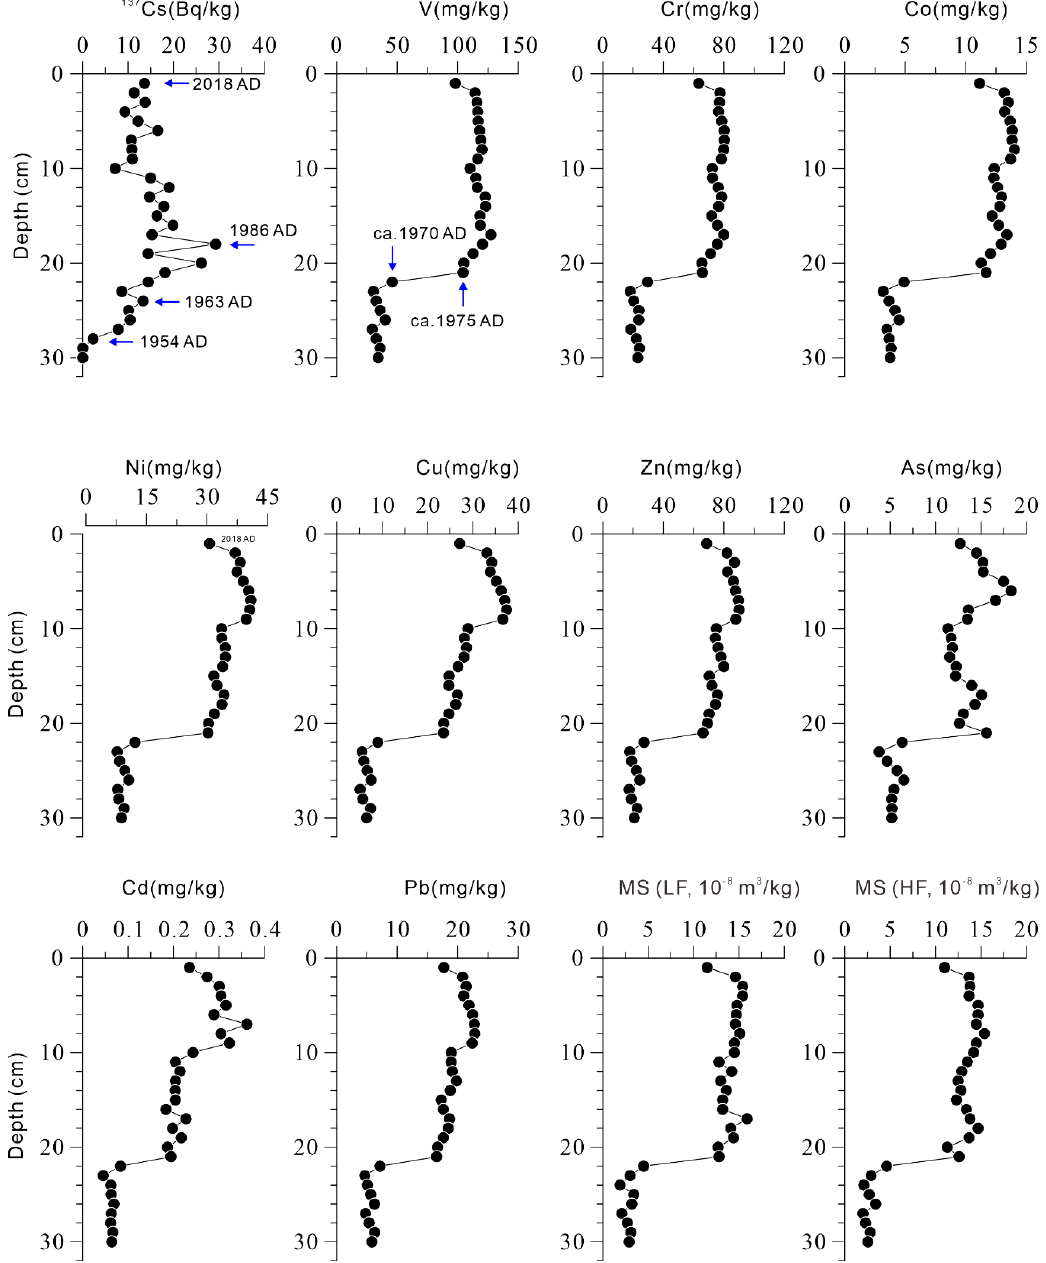
Figure 2. Vertical variations of 137 Cs, PTEs and magnetic susceptibility (MS) in lake sediments from North Aral Sea.